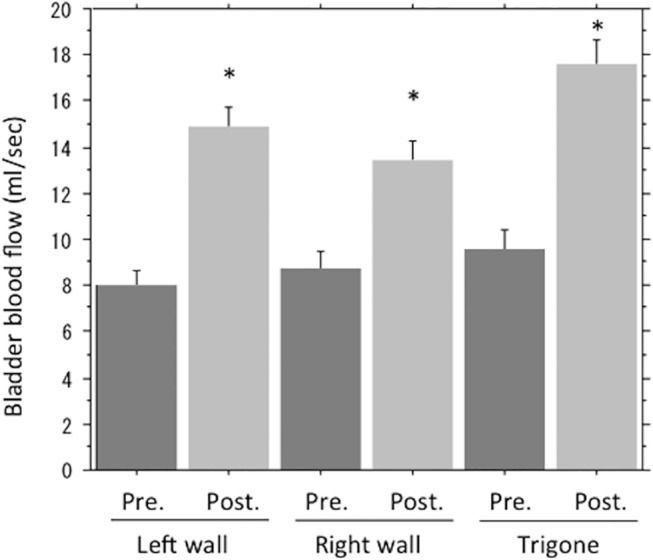
Bladder blood flow measured by LDF.Every region of the bladder including left wall, right wall, and bladder trigone showed a significant increase in blood flow as measured by LDF. *: p<0.001 Student’s t-test